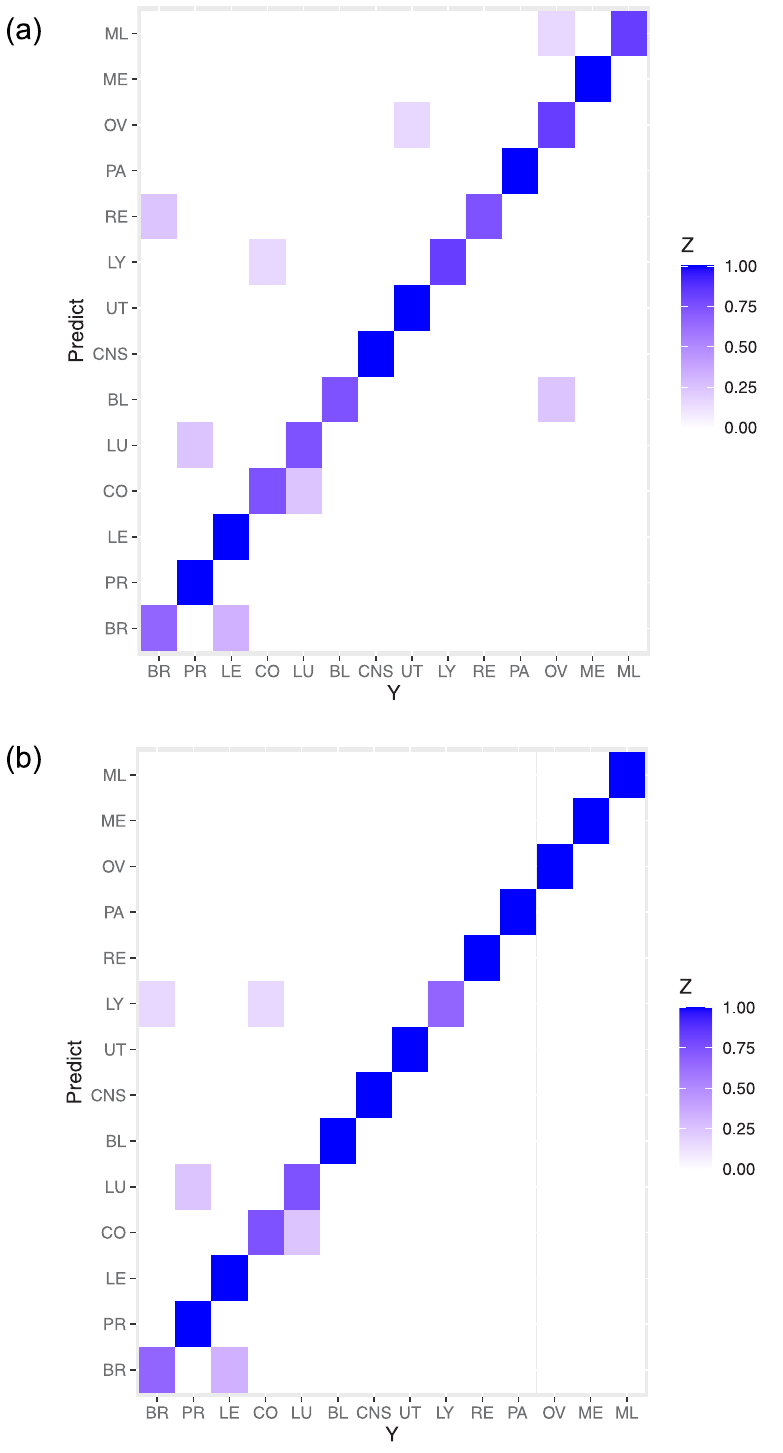
Fig 5. Heatmaps for the predicted values based on two proposed methods under the testing data. The left panel is obtained by Algorithm 1, the right panel is obtained by Algorithm 2. Z represents the proportion of (mis)classification.